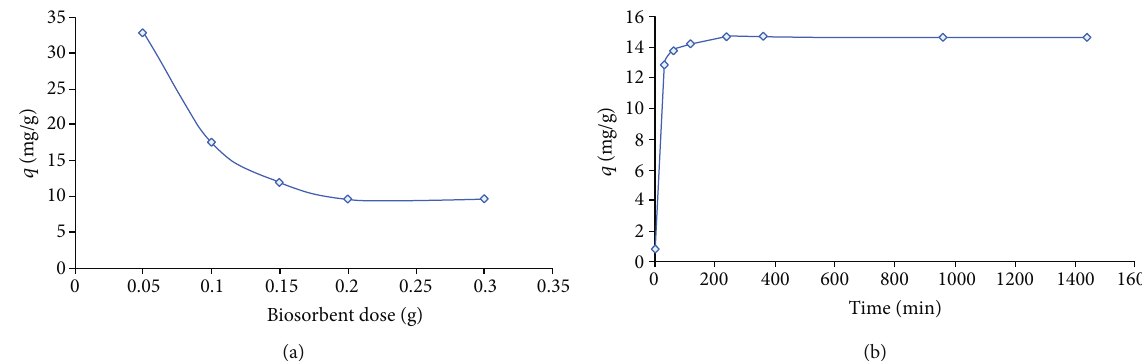
Figure 6: E ff ect of (a) biosorbent dose and (b) time on the removal of Drimaren Turquoise CL-B.